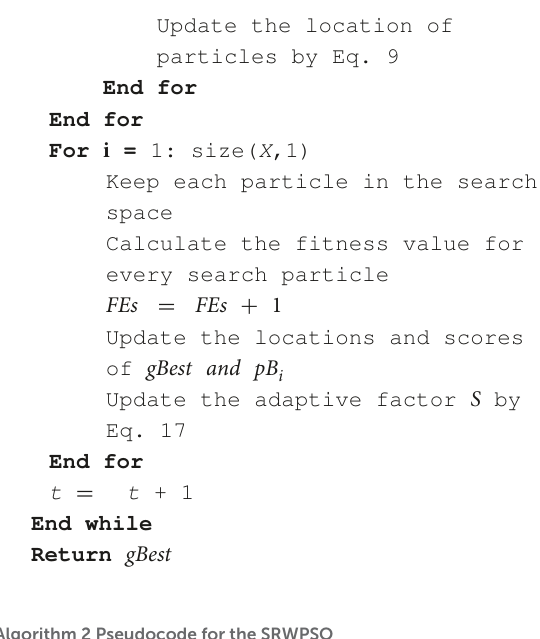
Algorithm 2 Pseudocode for the SRWPSO